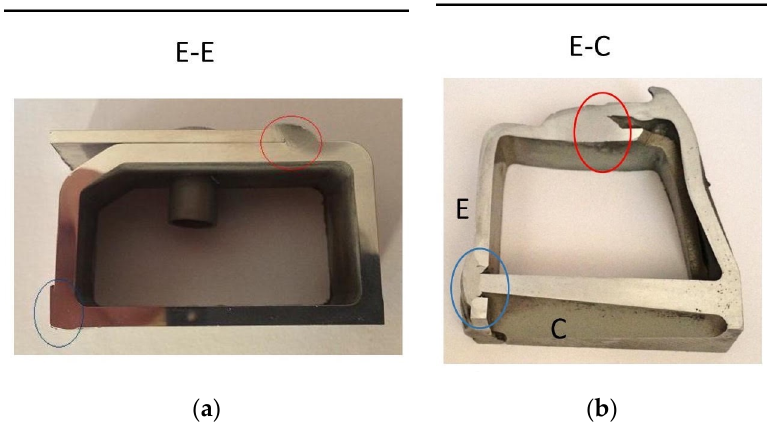
Figure 1. Samples obtained from the sub-frames: ( a ) extruded (6082-T6)-extruded (6082-T6) welds,